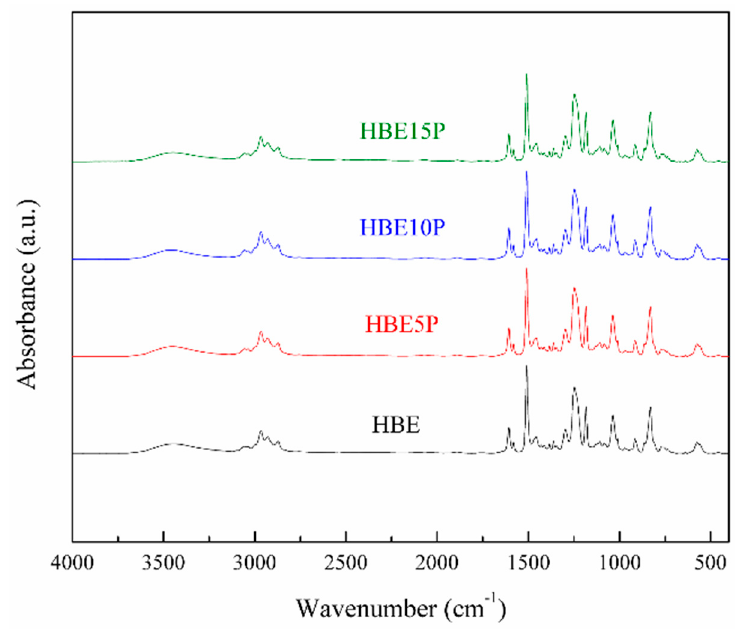
Figure 1. FTIR spectra of hyperbranched epoxy resins (HBE) at various polyethylene glycol (PEG) contents.